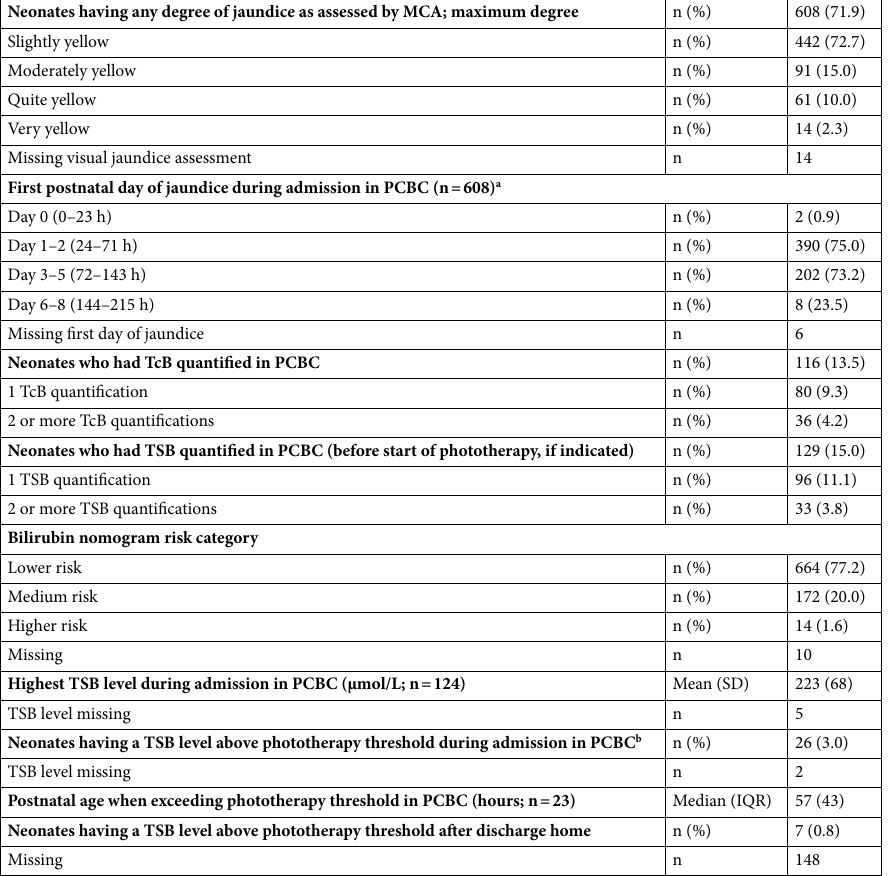
Table 2. Assessment and incidence of neonatal hyperbilirubinaemia. MCA maternity care assistant, PCBC primary care birth centre, TcB transcutaneous bilirubin, TSB total serum bilirubin, SD standard deviation, IQR interquartile range. a Percentage according to number of participating neonates that had some degree of jaundice during admission in the PCBC and were admitted in a participating PCBC at the time. b Phototherapy threshold according to the Dutch TSB nomogram 4,5